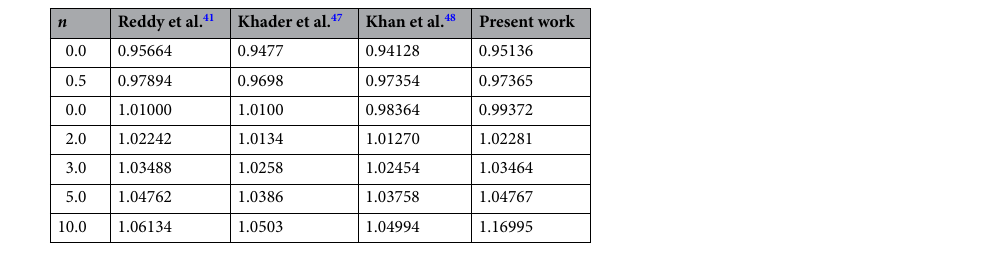
Table 3. Relative evaluation of current results with the available literature for − f ′′ ( 0 )